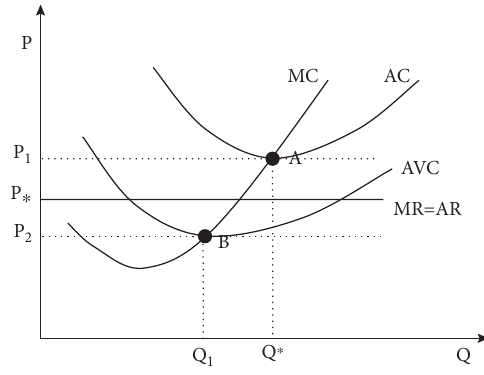
Figure 6: Food production decision under fixed